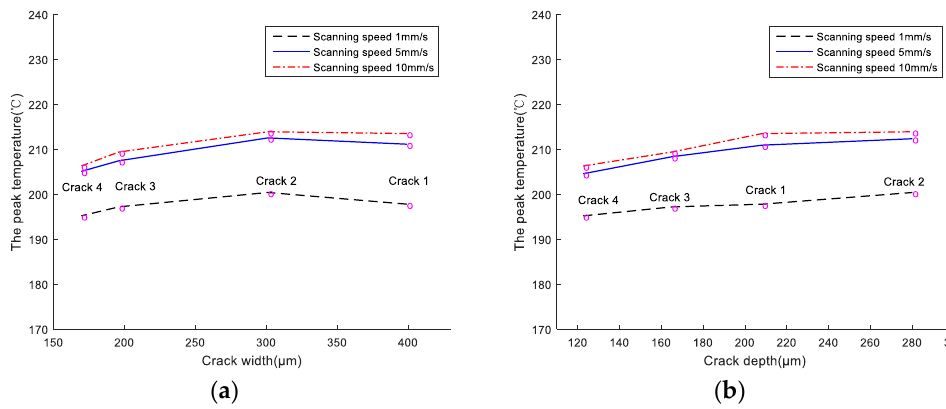
Figure 13. Curves of peak temperature versus crack ( a ) width and ( b ) depth obtained from the LMD-316L austenitic stainless-steel workpiece with simulated cracks.